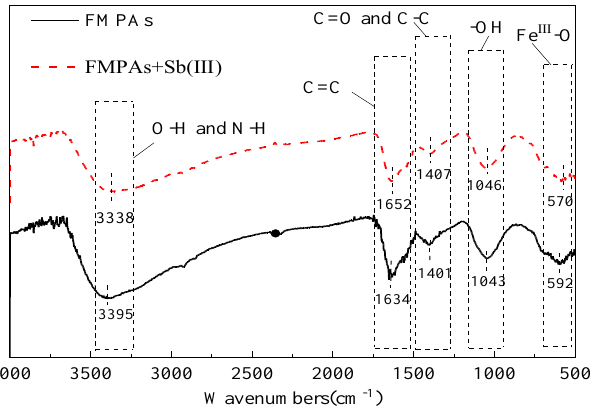
Figure 4. The infrared spectrum of FMPAs before modification, and FMPAs after adsorption S b( III